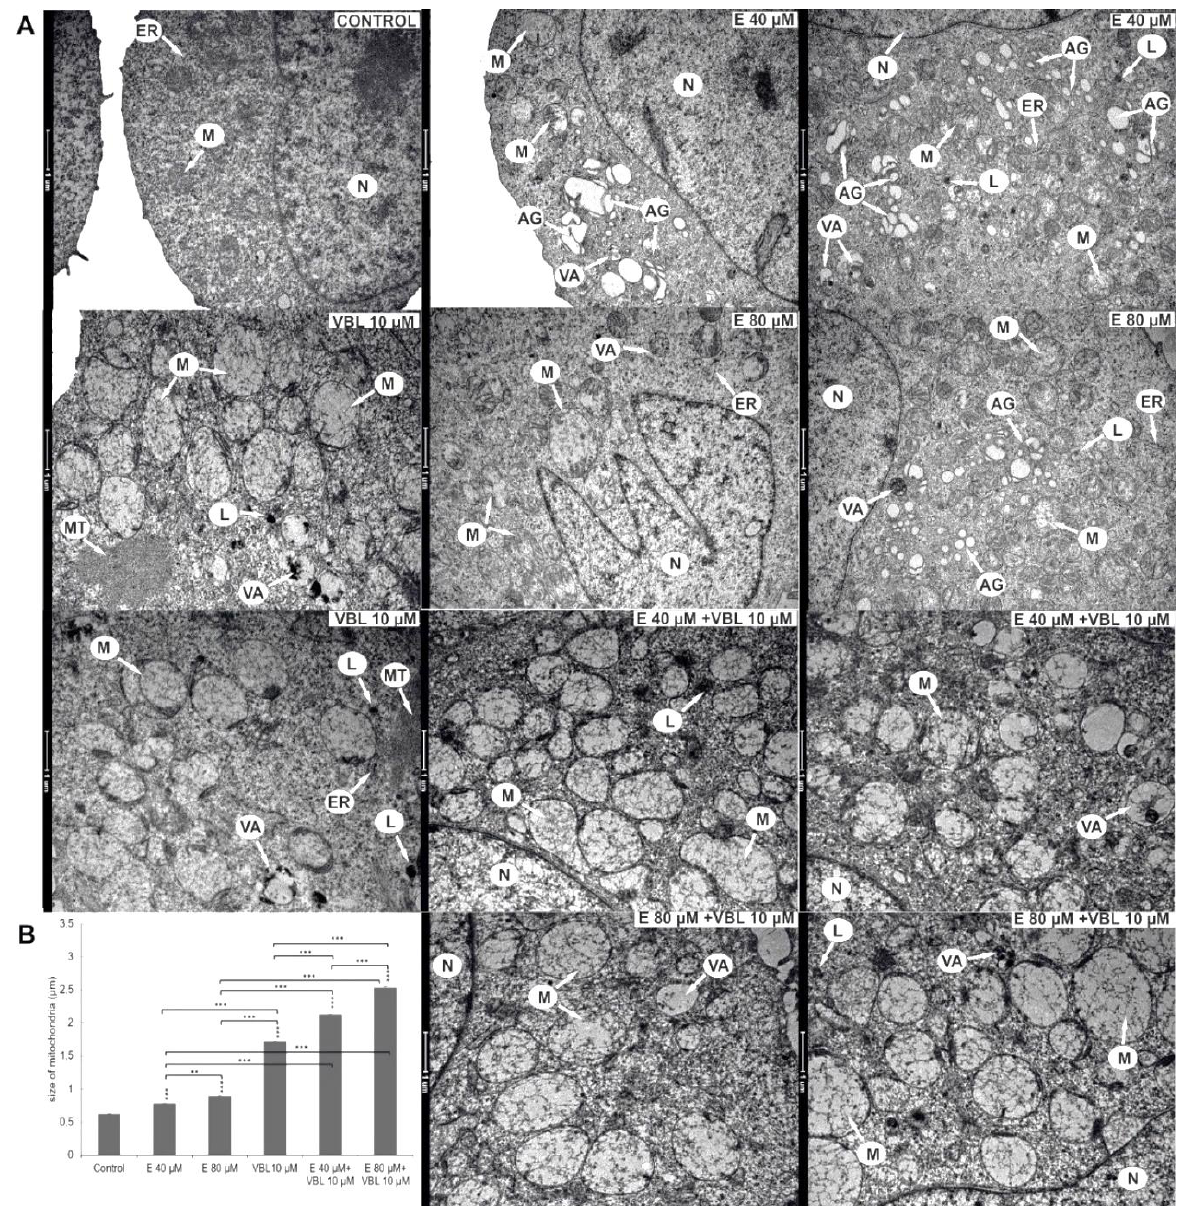
Figure 6. Ultrastructural changes in HeLa cells after 24 h of treatment with emodin, vinblastine and the combined action of both compounds. ( A ) Control — a cell with the correct nucleus and organelles with normal structure. Cells after the action of emodin (E 40 µM) with an increased number of Golgi apparatuses with swollen cisterns. Cells treated with emodin (E 80 µM) — extensive Golgi apparatuses with dispersed cisterns, numerous autophagic vacuoles, primary lysosomes and swollen mitochondria. Cells treated with vinblastine (VBL 10 µM) — the presence of swollen mitochondria with damaged cristae, autophagic vacuoles, lysosomes and cytoskeleton elements. Cells after the